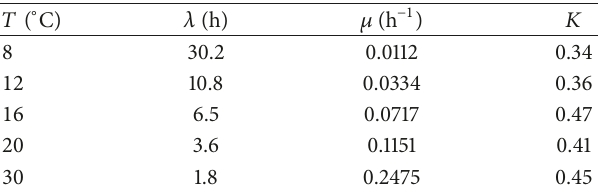
Table 3: Kinetic parameters ( 𝜆 and 𝜇 ) of experiments from previous data of Lactobacillus plantarum and calculated 𝐾